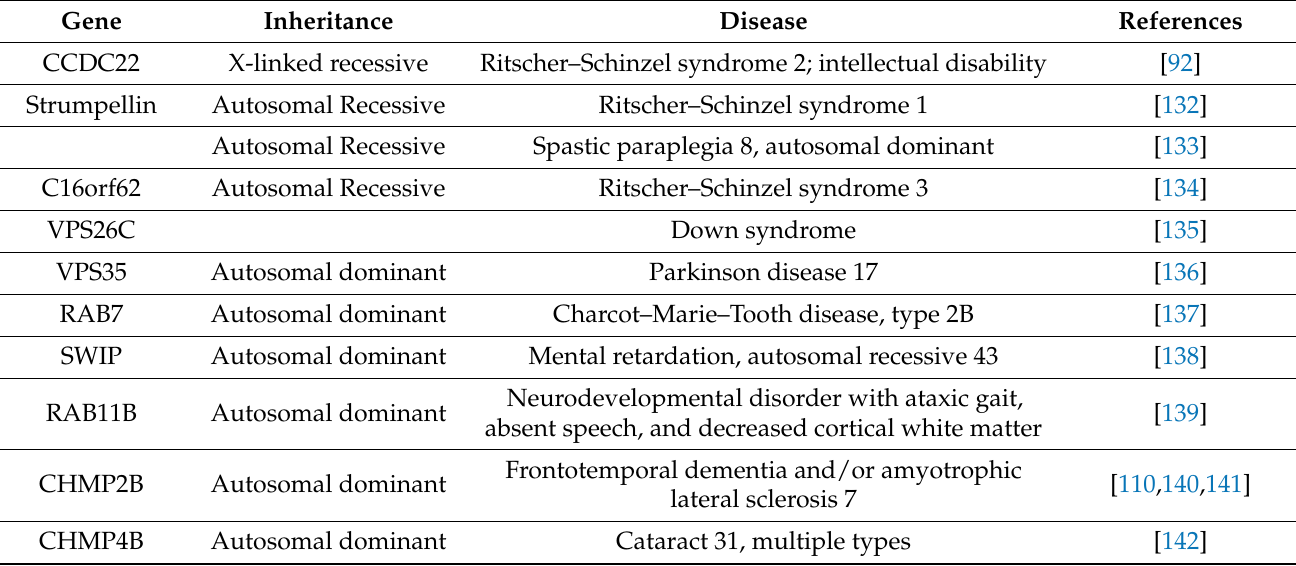
Table 1. List of sorting genes associated with neurological